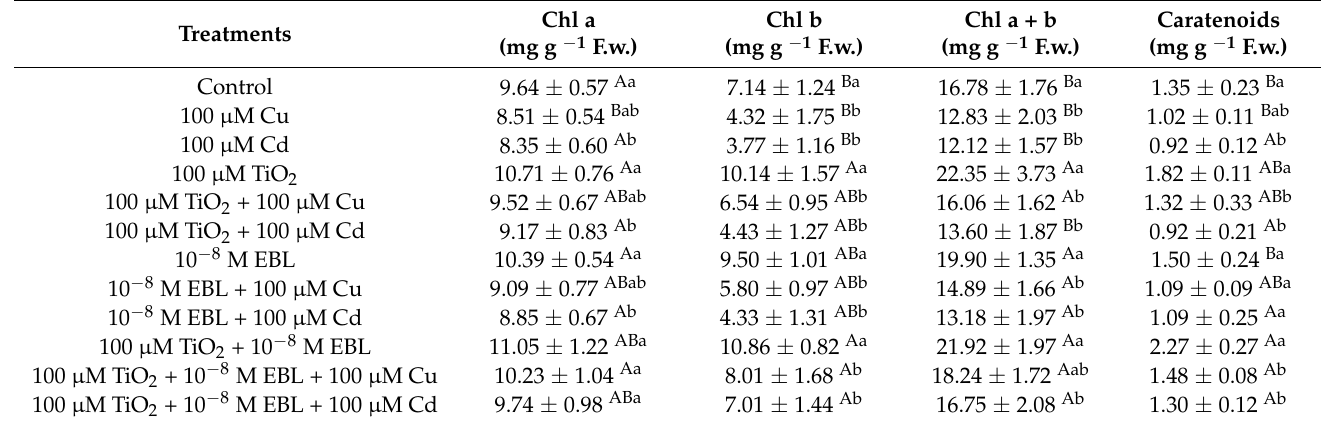
Table 2. The effect of the co-application of 24-epibrassinolide and titanium oxide nanoparticles individually and combined on photosynthetic pigments (Chl a, Chl b, and total Chl, as well as carotenoid contents) in bamboo species ( Pleioblastus pygmaeus ) with 100 µ M Cu and 100 µ M Cd.